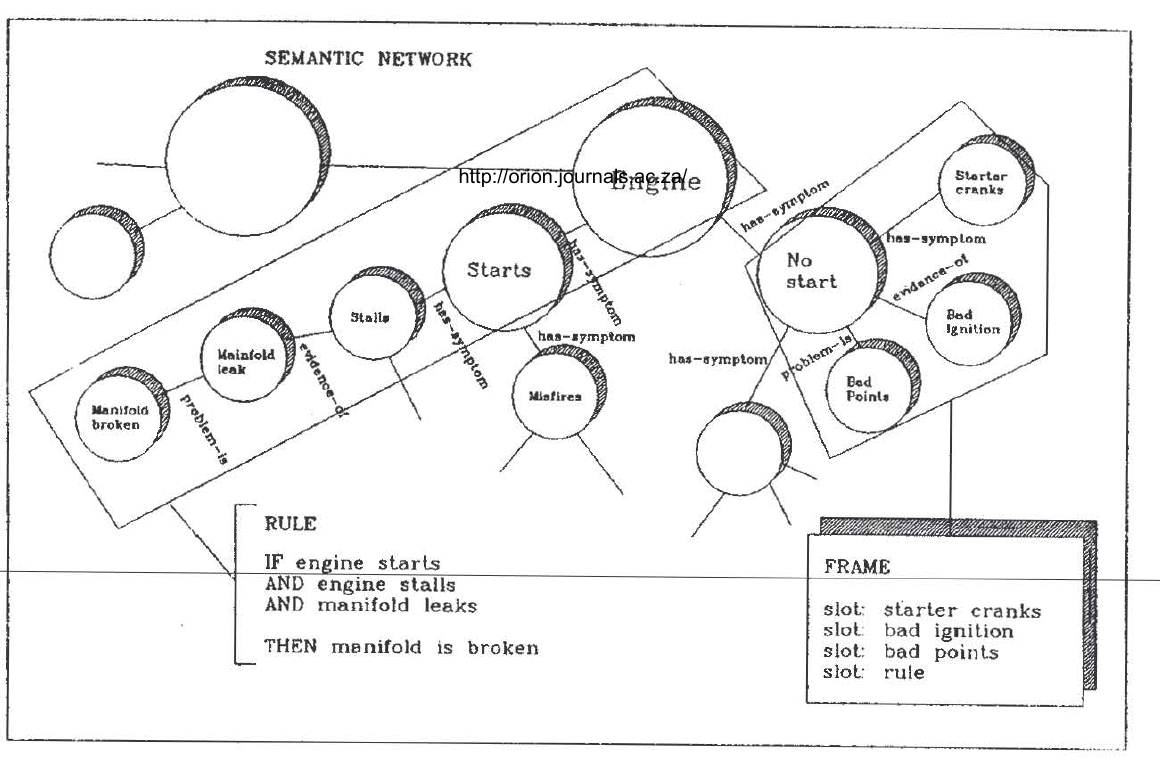
FIGURE 2: KNOWLEDGE REPRESENTATION